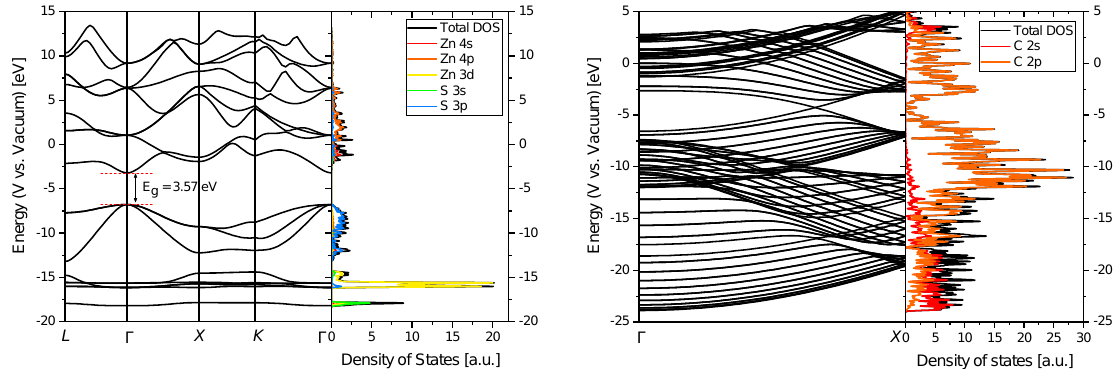
Figure 5. Band structure and orbital projected density of states of s-ZnS ( left ) and a 10,10 carbon nanotube (CNT) ( right